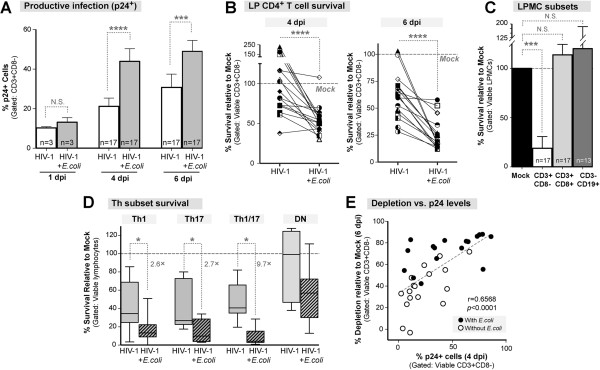
Commensal E. coli enhance apoptosis in productively infected LP CD4+ T cells. (A) Commensal E. coli increases the frequency of productively infected cells. The percentage of p24+ cells in the presence of a 5:1 E. coli: LPMC ratio was quantified using intracellular p24 expression. Significance was determined using the Wilcoxon matched-pairs signed rank test. (B) LP CD4+ T cell survival was compared in the presence of absence of E. coli normalized to mock (100% survival). Significant differences in cell survival at 4 dpi or 6 dpi were determined using the Wilcoxon matched-pairs signed rank test. (C) Cell-specificity of HIV-1 mediated depletion in the LPAC model. The percent survival relative to mock infection at 6 dpi was determined for CD3+CD8- T cells (white), CD3+CD8+ T cells (light grey), and CD3-CD19+ B cells (dark grey). The black bar depicts 100% survival for each cell type in the mock infected condition, also indicated by the dashed horizontal line. Significance was determined using the Kruskal-Wallis test and Dunn’s multiple comparison tests to compare selected pairs of columns. (D) Th Subset survival was determined following stimulation with PMA/Ionomycin. Viable cell counts were obtained prior to PMA/Ionomycin and multipled by the percentage of CD3+CD8- T cells expressing cytokine. Survival was determined normalized to mock infection for all subsets. Box and whiskers indicate the median and range respectively. Significant differences in cell survival for each subset were determined using the Wilcoxon matched-pairs signed rank test. (E) Spearman rank correlation analysis between the percentage of p24+ cells at 4 dpi and the level of LP CD4+ T cell depletion at 6 dpi. The best-fit line, Spearman r and the p value are indicated. *p = <0.05; ***p = 0.0005; ****p < 0.0001.